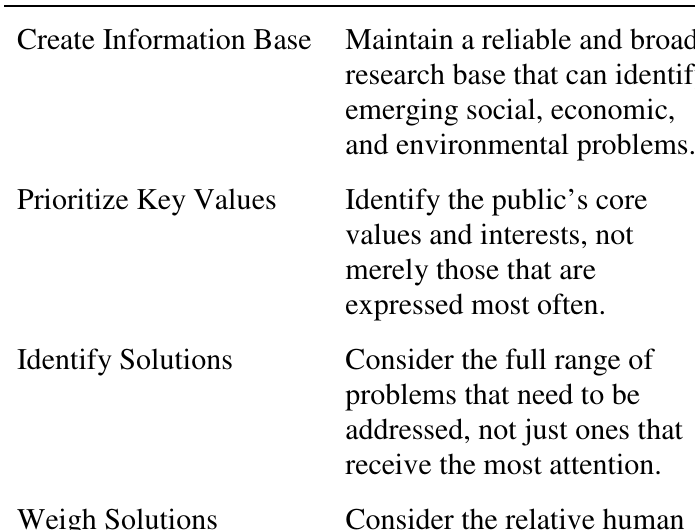
Table 4 Key Features of Legislative Deliberation Analytic